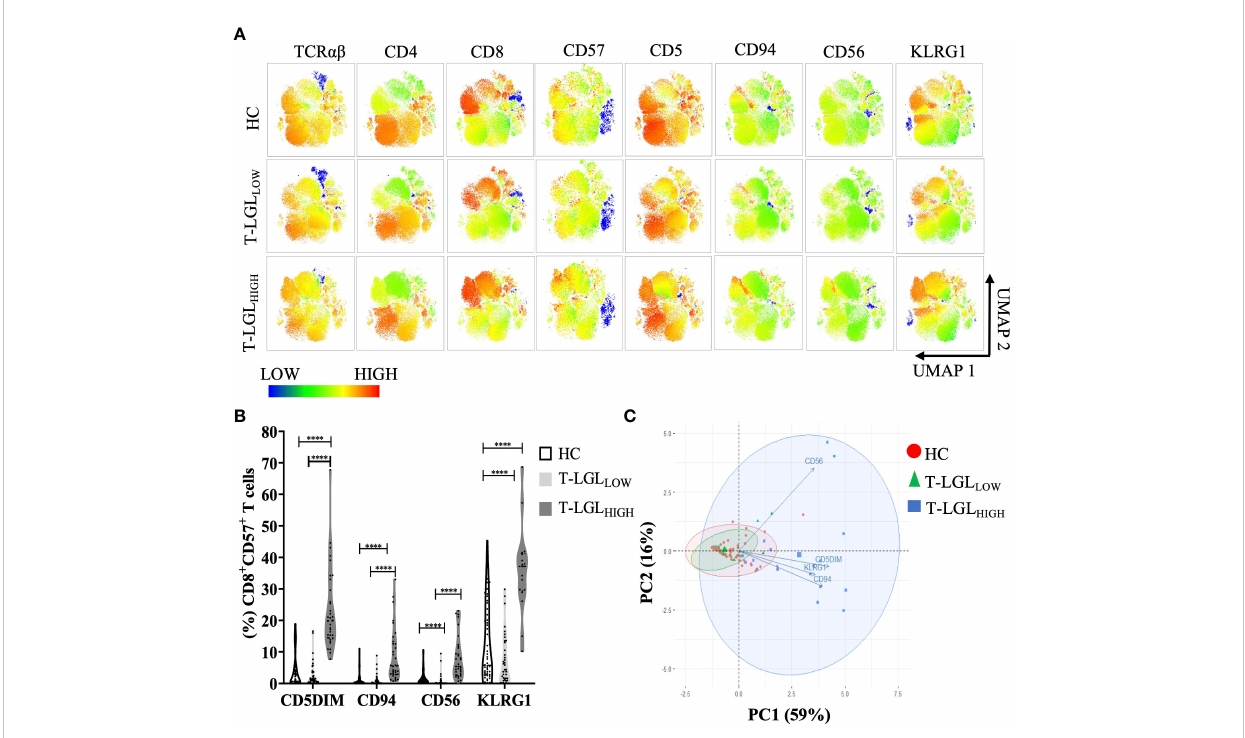
FIGURE 3 Immunophenotyping of CD3 + T cells in HC and IBM patients. (A) UMAP heat-map analysis. We selected a total of 50,000 T cells per donor group (HC n=54, T-LGL NEG n=42, T-LGL POS n=17), and concatenated into a single matrix. T cells were identi fi ed based on the signal expression intensity of the phenotypical markers TCR ab , CD4, CD8, CD57, CD5, CD94, and KLRG1. (B) Median frequency of surface markers in CD8 + CD57 + T cells. Statistical analysis was performed individually for each surface antigen using the Kruskal-Wallis ANOVA with Dunn ’ s post-hoc test for multiple comparisons. Healthy controls (n=56), IBM T-LGL LOW (n=51), and IBM T-LGL HIGH (n=34). KLRG1 was analyzed in HC (n=54), IBM T-LGL LOW (n=41), and IBM T-LGL HIGH patients (n=17). The full comparison of the descriptive statistics for each surface marker is shown in Supplementary Table 2. (C) . Principal Component Analysis of immune cell phenotypes in CD8 + CD57 + T cells. Each immunophenotype was visualized in 2 dimensions (PC1 and PC2). **** : P <